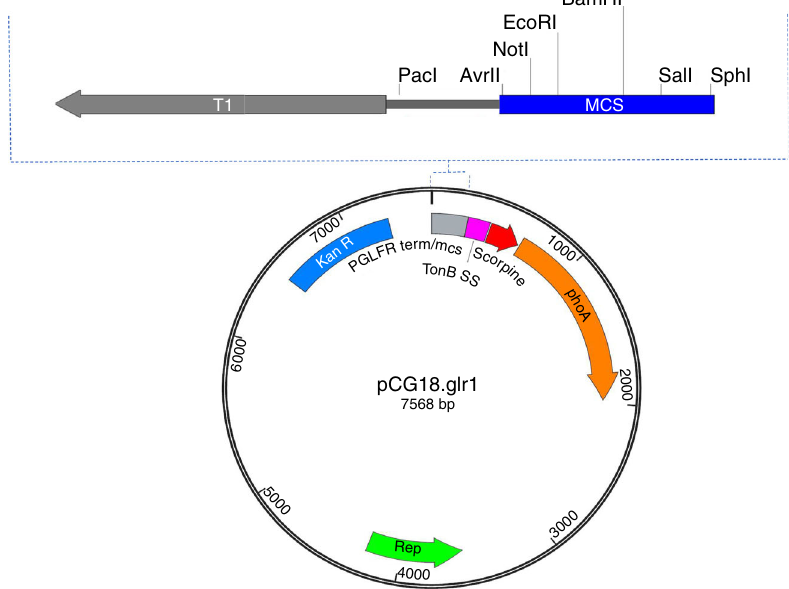
Fig. 3 Antiplasmodial vector pCG18.glr1. BMI promoters were added at the multiple cloning site to drive the antiplasmodial effector scorpine in the promoterless pCG18.glr1. This plasmid was generated from the fusion of the promoter region of pGLR1 into the constitutive antiplasmodial plasmid pCG18 that contains a secreted protein fusion of scorpine and alkaline phosphatase. T1 transcriptional terminator from E. coli rrnB , Rep pBBR1 origin of replication, KanR kanamycin resistance, mcs multiple cloning site, TonB SS Asaia TonB dependent signal sequence for secretion, phoA E. coli alkaline phosphatase